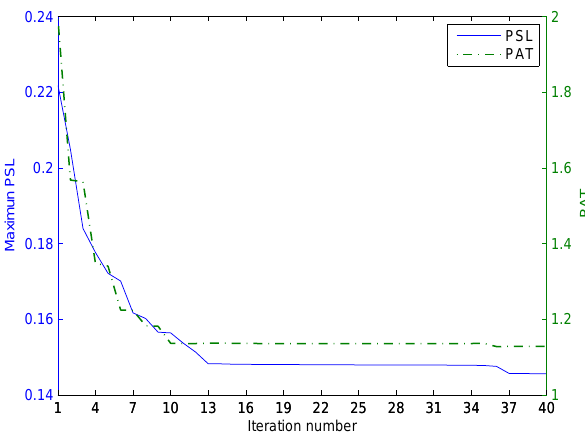
Figure 10. The iterative process of optimization in the first stage for the one-main-lobe.